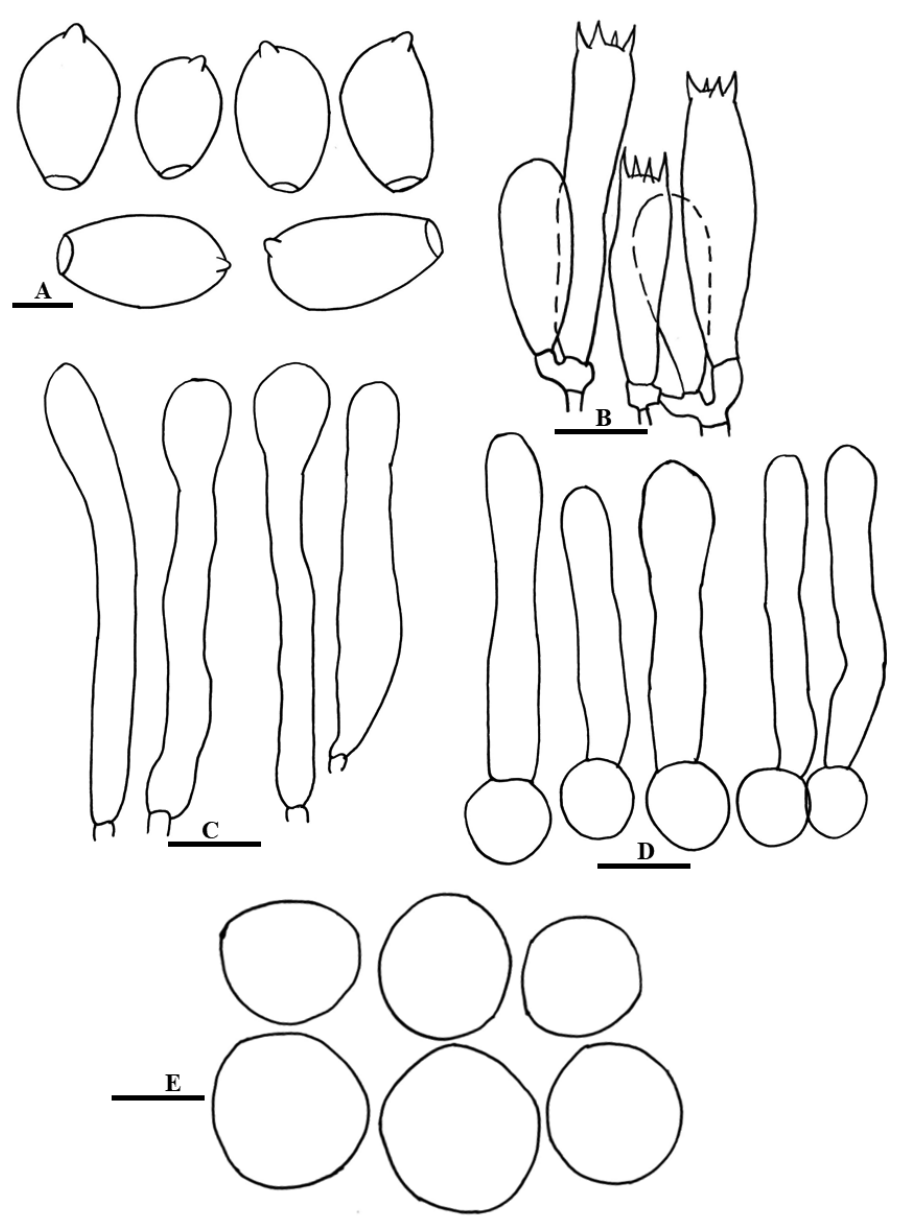
Figure 5. Line drawing of anatomical characters of Coprinellus disseminatus-similis A Basidiospores B Ba- sidia C Cheilocystidia D Pileipellis with pileocystidia E Veil elements. Scale bars: 10 µm ( A ), 20 µm ( B–E ). Comments. The new species would be placed in sect. Setulosi because of its pileo- cystidia. However, as with Co. disseminatus , which it resembles and is close to in the molecular phylogram, Co. disseminatus-similis falls in a clade along with members